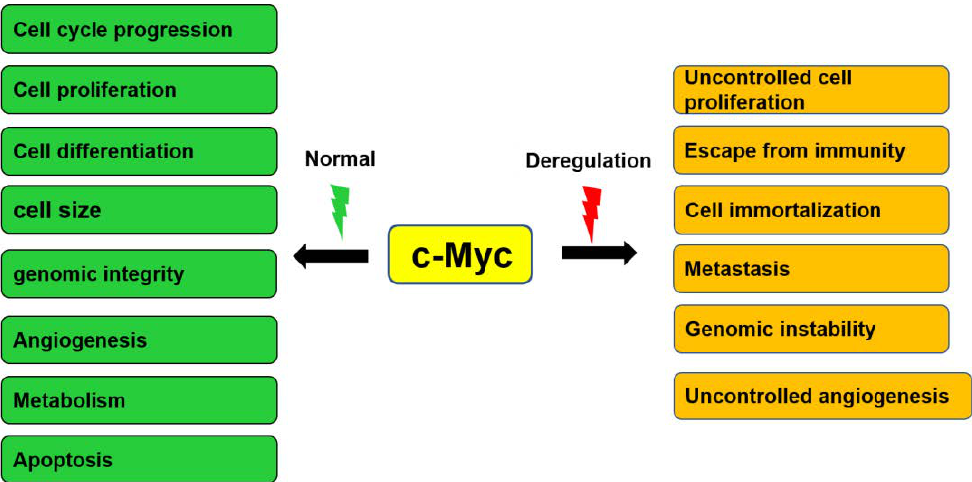
Figure 2. Cellular functions controlled by c-Myc during normal conditions and tumorigenesis. c-Myc mediates numerous biological effects, including cell cycle progression, cell proliferation, cell differentiation, cell size, genomic integrity, angiogenesis, cell metabolism, and apoptosis. Deregulation of c-Myc may result in uncontrolled cell proliferation, escape from immunity, cell immortalization, metastasis, genomic instability, and uncontrolled angiogenesis.